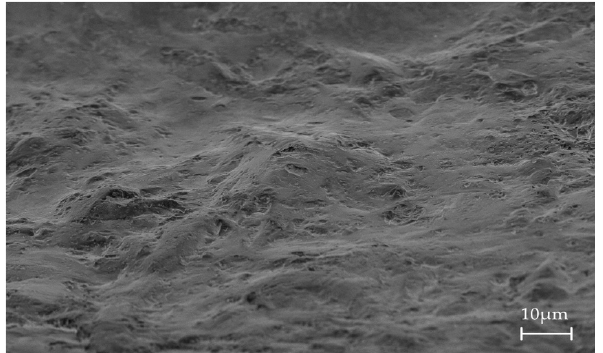
Figure 6. SEM-Image of a whiteSKY zirconia implant, 2000-fold magnification.